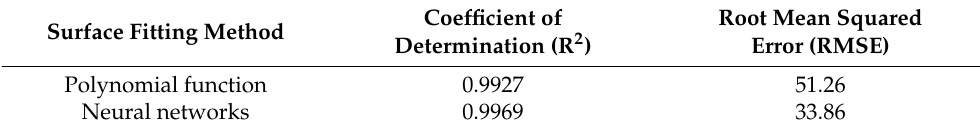
Table 3. The fitting error of sandpile